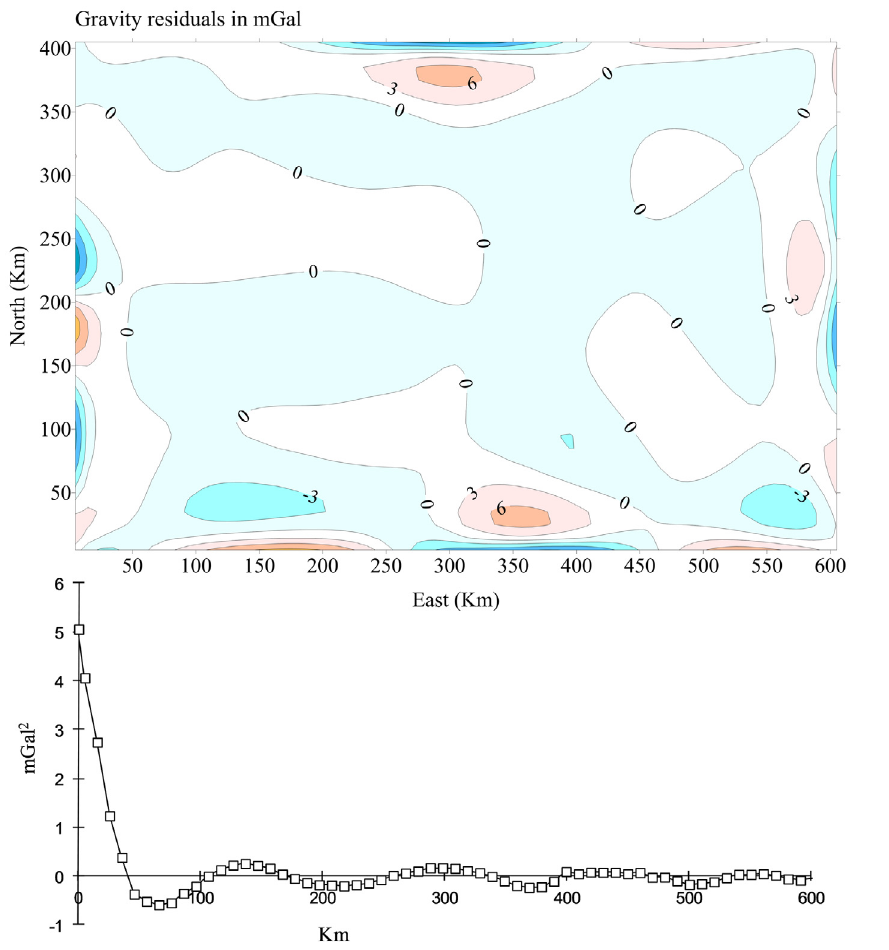
Figure 5. Integrated inversion 3: gravity residuals and their covariance